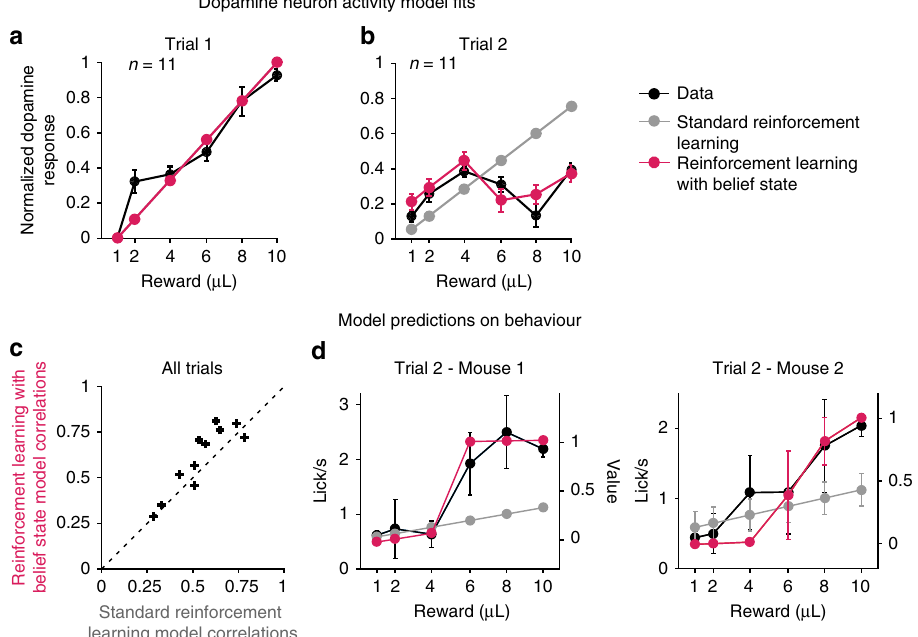
Fig. 4 RL with belief states explains dopamine reward responses and behavior better than standard RL. Individual DA responses to rewards were fi t using either a standard RL model or a RL model computing values on belief states. a Fits to dopamine responses on trial 1. Both RL models fi t the dopamine response, since on trial 1 there is no evidence to infer a state on. b Fits to dopamine responses on trial 2. Only computing RPEs using belief states reproduced the non-monotonic change in dopamine response across increasing rewards. c Model predictions on behavior. The value functions from either model fi ts were positively correlated with the mice ’ s anticipatory licking, but the RL model with belief state provided a better fi t (signed rank test: p = 0.032), suggesting that mice ’ s anticipatory licking tracks the value of the belief state. d Individual examples of extracted value function from either model and anticipatory licking across increasing rewards on trial 2. n = 11, data represent mean ±